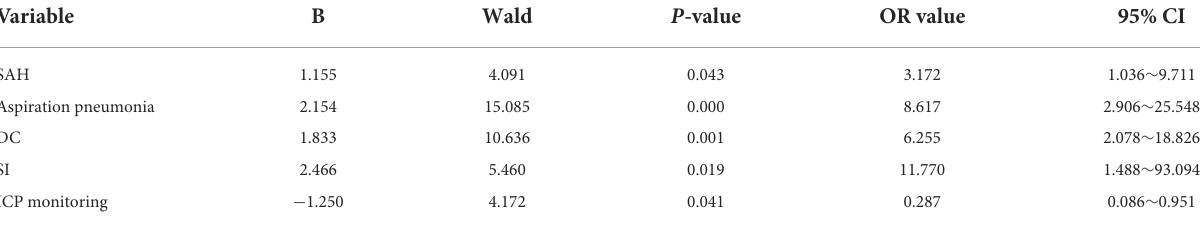
TABLE 3 Multivariate analysis of the risk of